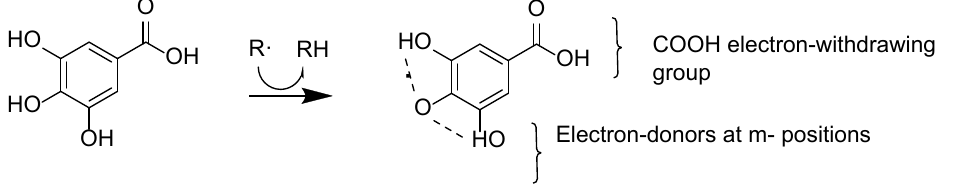
Figure 10. Abstraction of an H atom from the p position and stabilization of the resulting radical through intramolecular hydrogen bonding with the m- O-H groups [57].